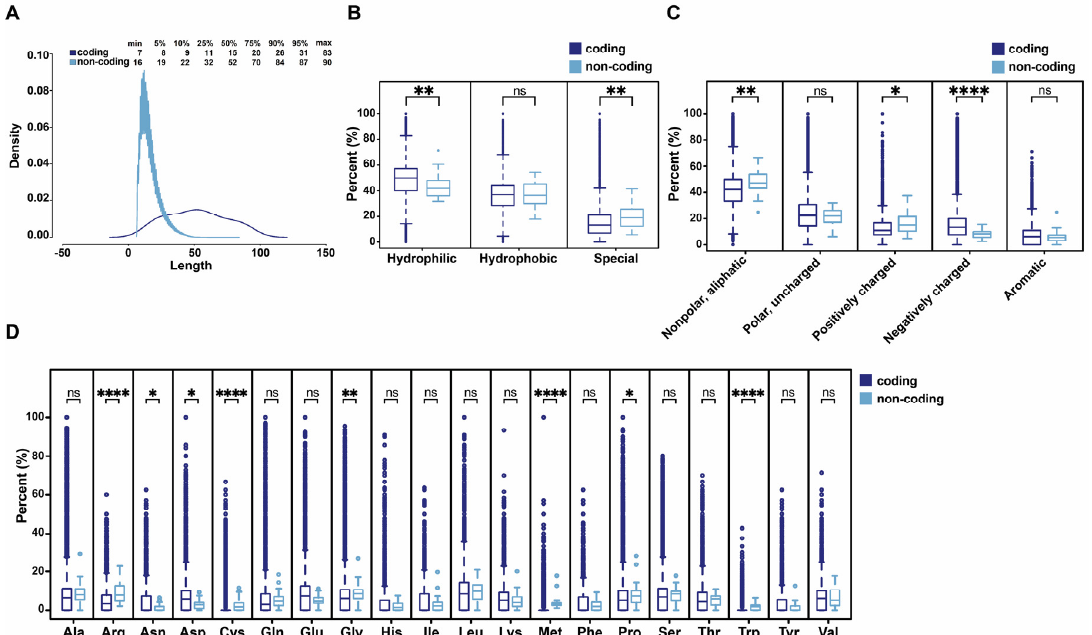
Figure 4. Up-to-date comparison of human functional ncPEPs with human peptides from coding regions. ( A ) Comparison of the size range between human ncPEPs and peptides from coding regions. ( B ) Comparison between human ncPEPs and peptides from coding regions according to the properties of the amino acids (hydrophobic, hydrophilic, and special). ( C ) Comparison between human ncPEPs and peptides from coding regions according to the chemistry of the R groups (aromatic R groups; nonpolar aliphatic R groups; negatively charged R groups; positively charged R groups; and polar uncharged groups). ( D ) Comparison between human ncPEPs and peptides from coding regions according to the amino acid distribution. Due to a not normally distributed dataset, data is presented using box plots with whiskers representing 1.5 times the interquartile range. (Mann–Whitney–Wilcoxon test with Benjamini & Hochberg correction for multiple testing; ns—not significant, * p < 0.05; ** p < 0.01; **** p <